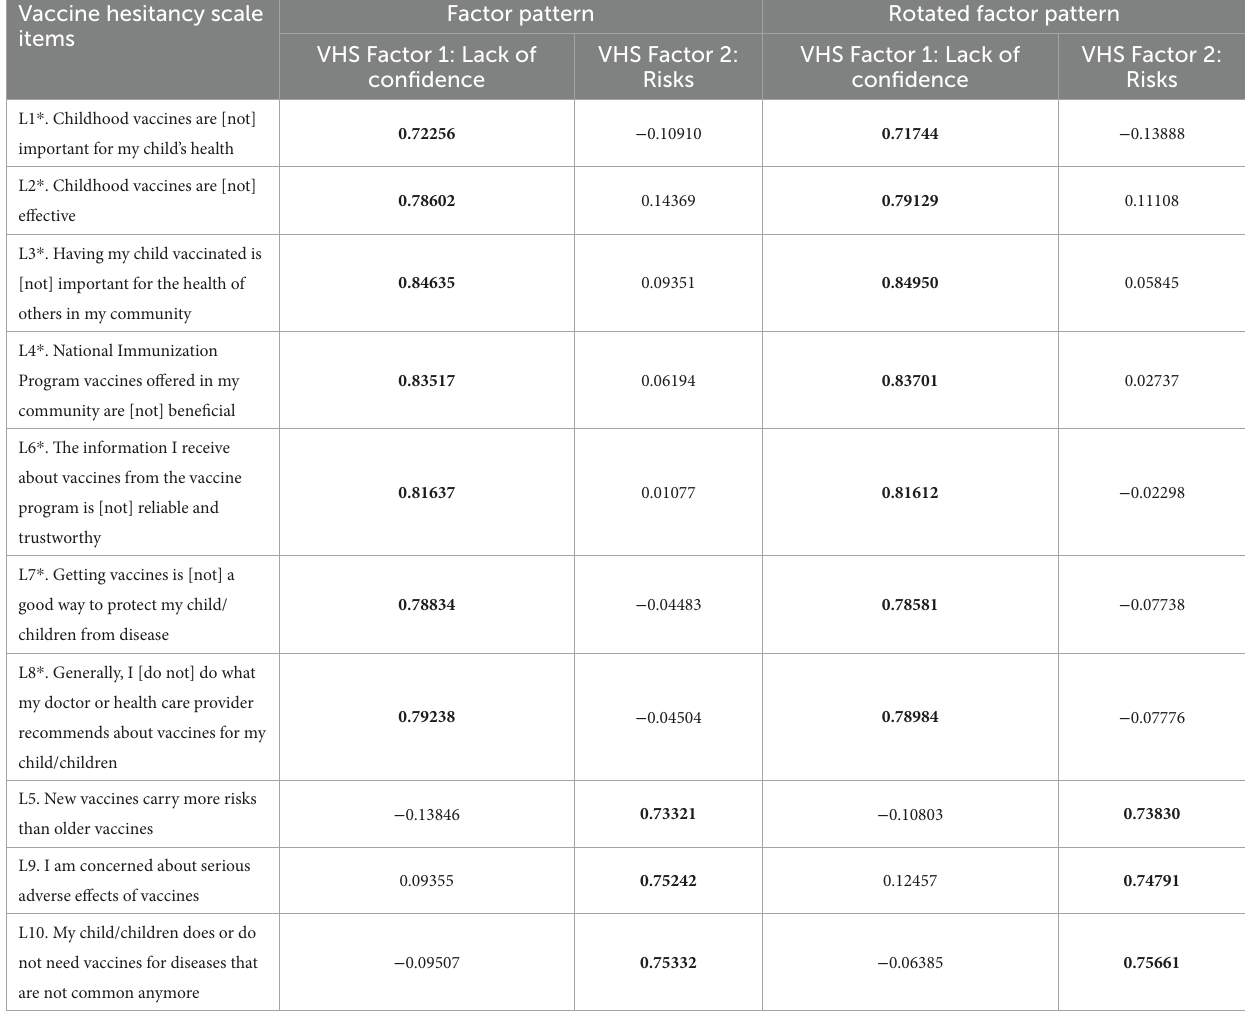
TABLE 2 Unrotated and rotated exploratory factor analysis factor loading pattern for the vaccine hesitancy scale items. Vaccine hesitancy scale